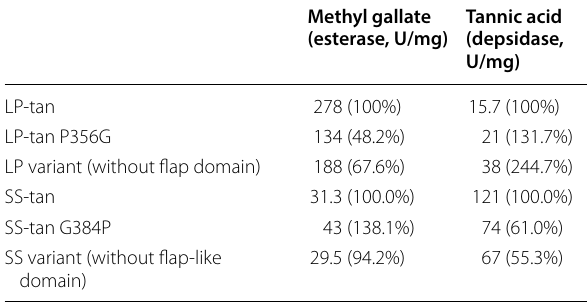
Each experiment was performed in quintuplicate, and the averages were used to build this table. In all the cases, the observed wild-type tannase (LP-tan and SS-tan) activity was defined as 100%